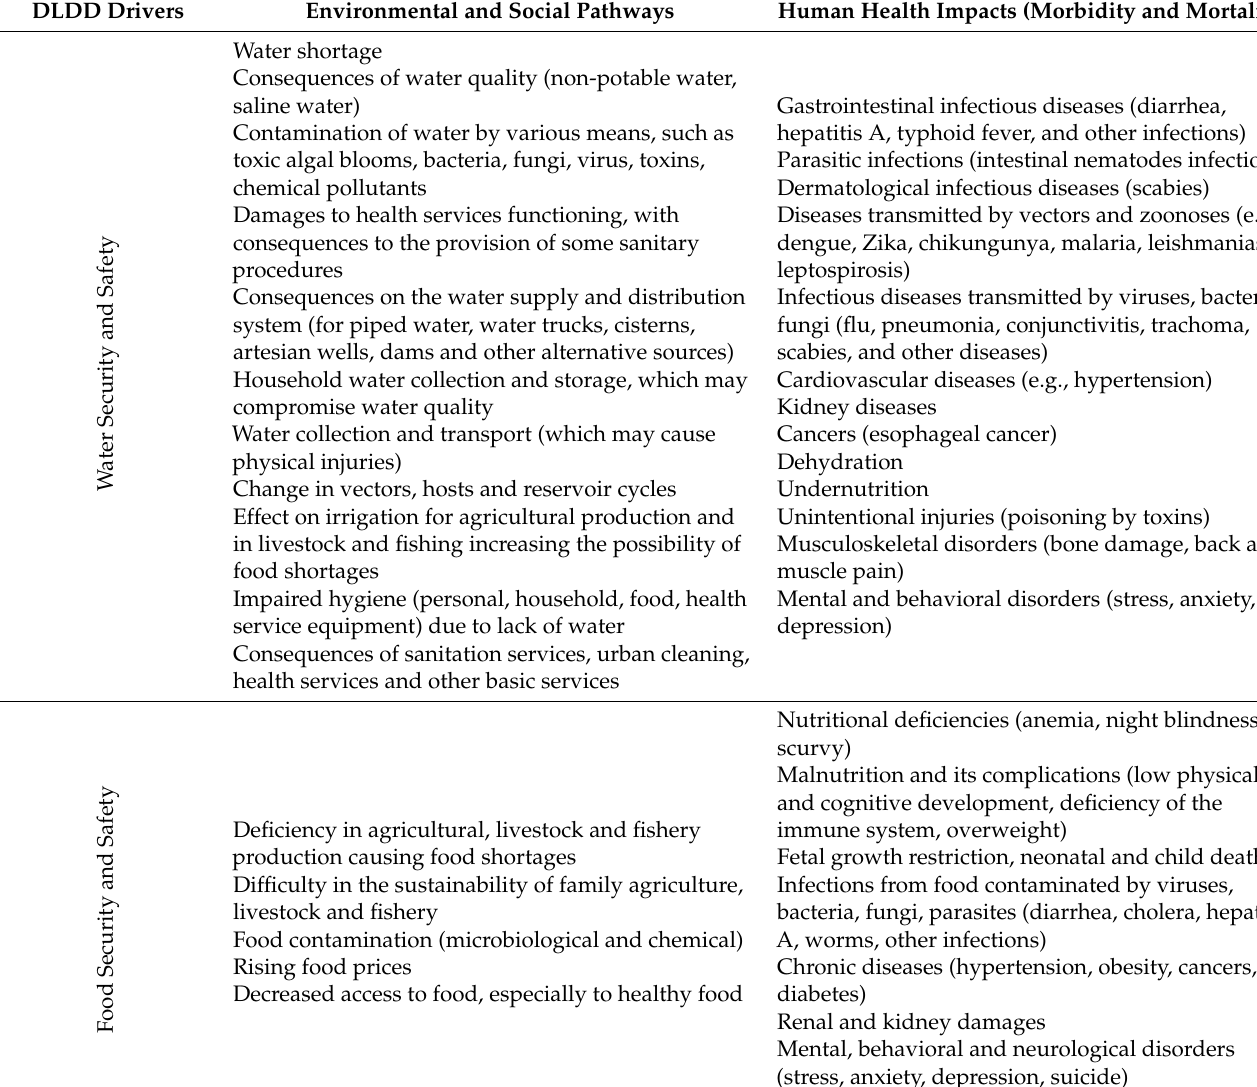
Table 1. DLDD drivers affecting human health through water security and safety, sanitation and hygiene, food security and safety, and air and soil quality. DLDD